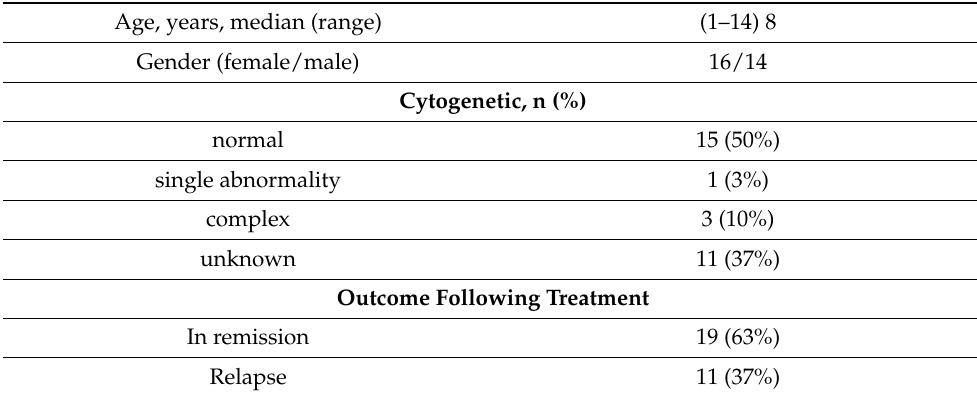
Table 2. Clinical information of ALL